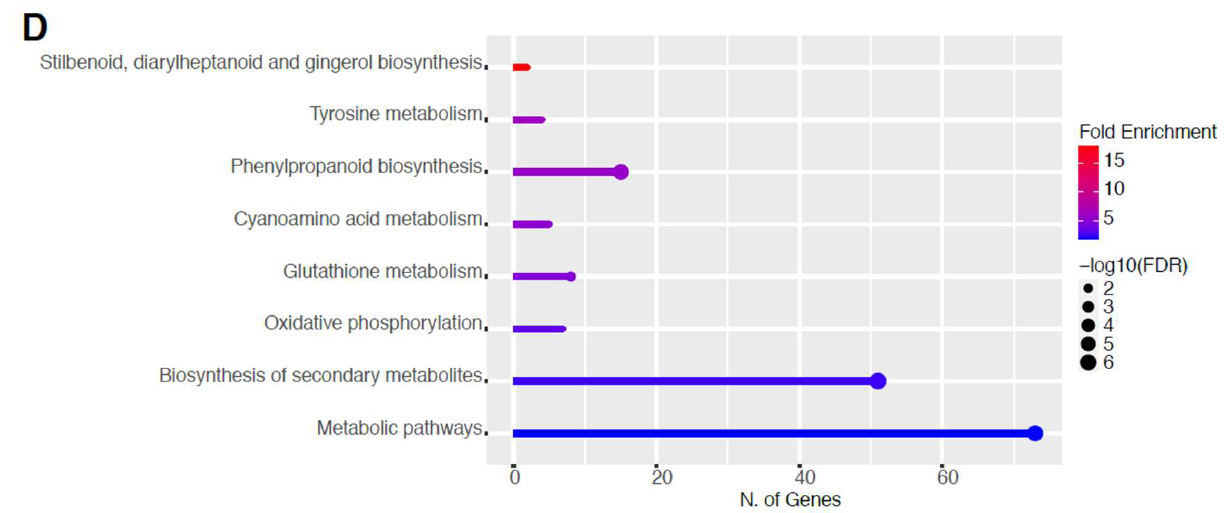
Figure 8. Gene enrichment analysis for downregulated genes after 80 s plasma treatment. Lollipop diagrams provide information about GO fold enrichment, significance (FDR in log10), and number of genes in each pathway. From top to bottom, GO categories are in the following order: ( A ) biological process, ( B ) cellular component, ( C ) molecular function, and ( D ) KEGG pathway.